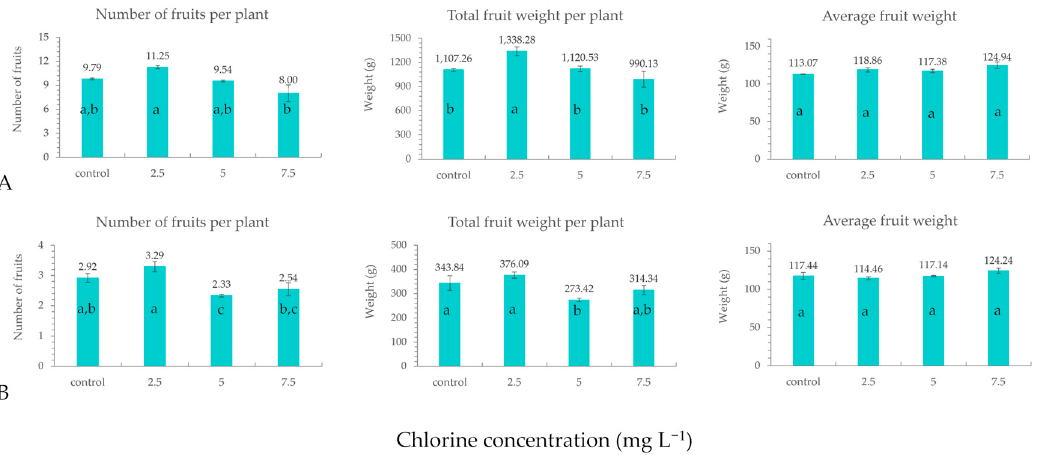
Figure 1. ( A ) Total and ( B ) Extra class production of tomato fruit after disinfection of the nutrient solution using sodium hypochlorite in an open soilless system applying chlorine concentrations of 2.5, 5 and 7.5 mg L − 1 . Values (means of four replications, bars = SE), followed by different letter in each column indicate significant differences according to Duncan’s multiple range test ( p < 0.05).